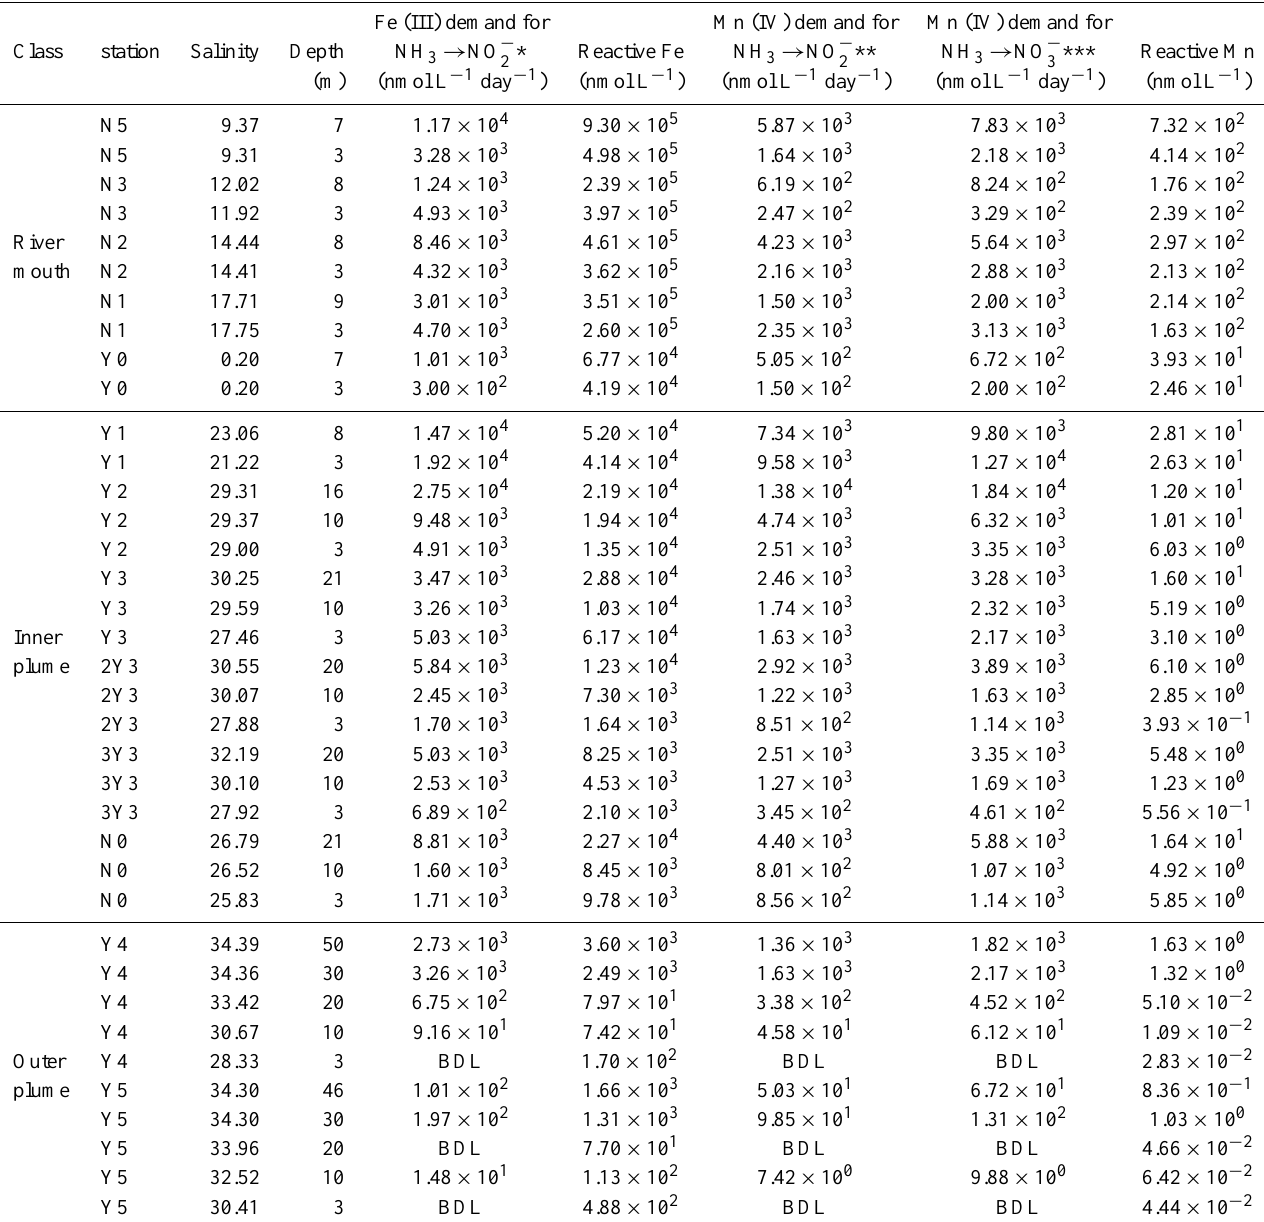
Table 3. Estimated Fe (III) and Mn (IV) demand for nitrification and the observed concentrations along the Chang Jiang River plume. Fe (III) demand